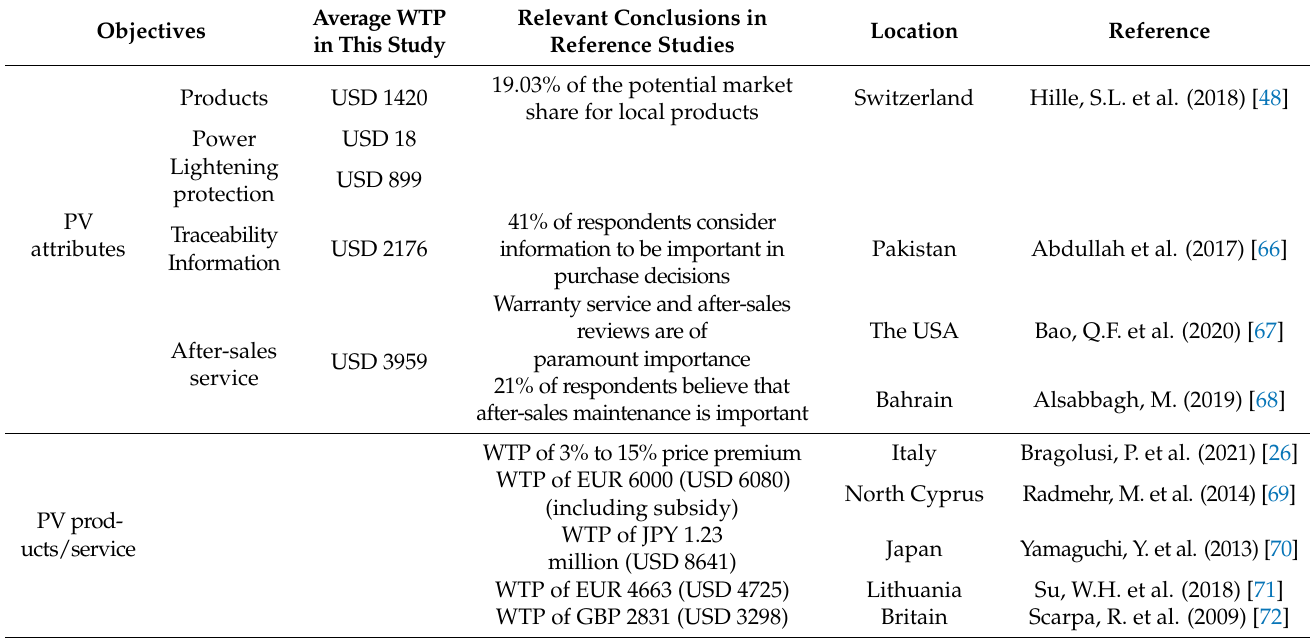
Table 9. Comparison with the results of other